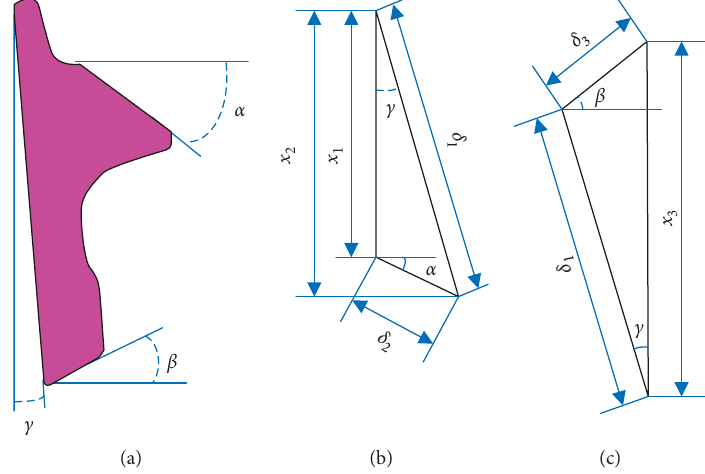
Figure 2: (a) Angle and (b) displacement of each friction